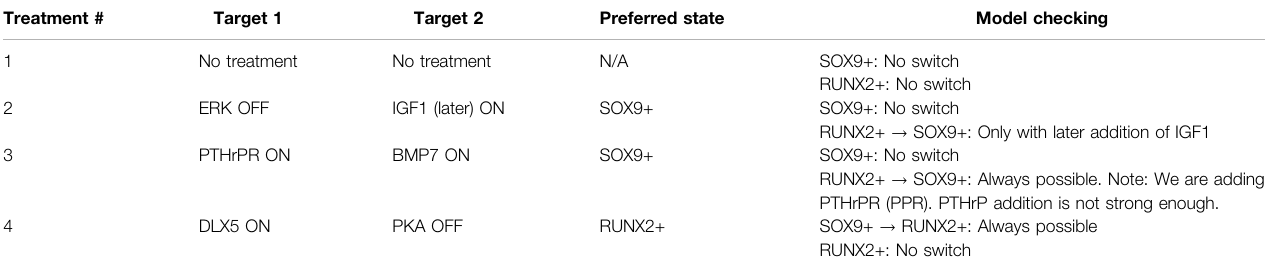
TABLE 3 | Model checking was performed on a selection of combinations of nodes that were predicted to switch cell fate to a preferred SOX9+ fate or a RUNX2+ state. All treatments were tested using both the SOX9+ and RUNX2+ initial states. “ No switch ” means that the initial state is constantly preserved, i.e., that the property “ [initial state] must persist inde fi nitely ” is true. “ Always possible ” means that the model is guaranteed to switch state, i.e., the property “ [opposite state] can always be reached ” is true. Treatment